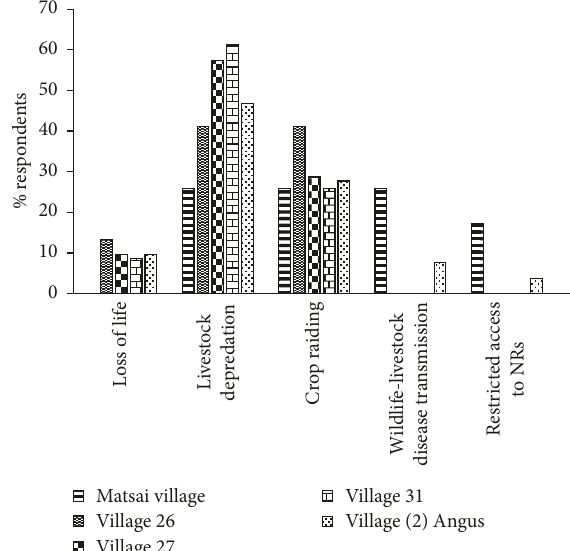
Figure 4: Nature of costs incurred by local communities across the